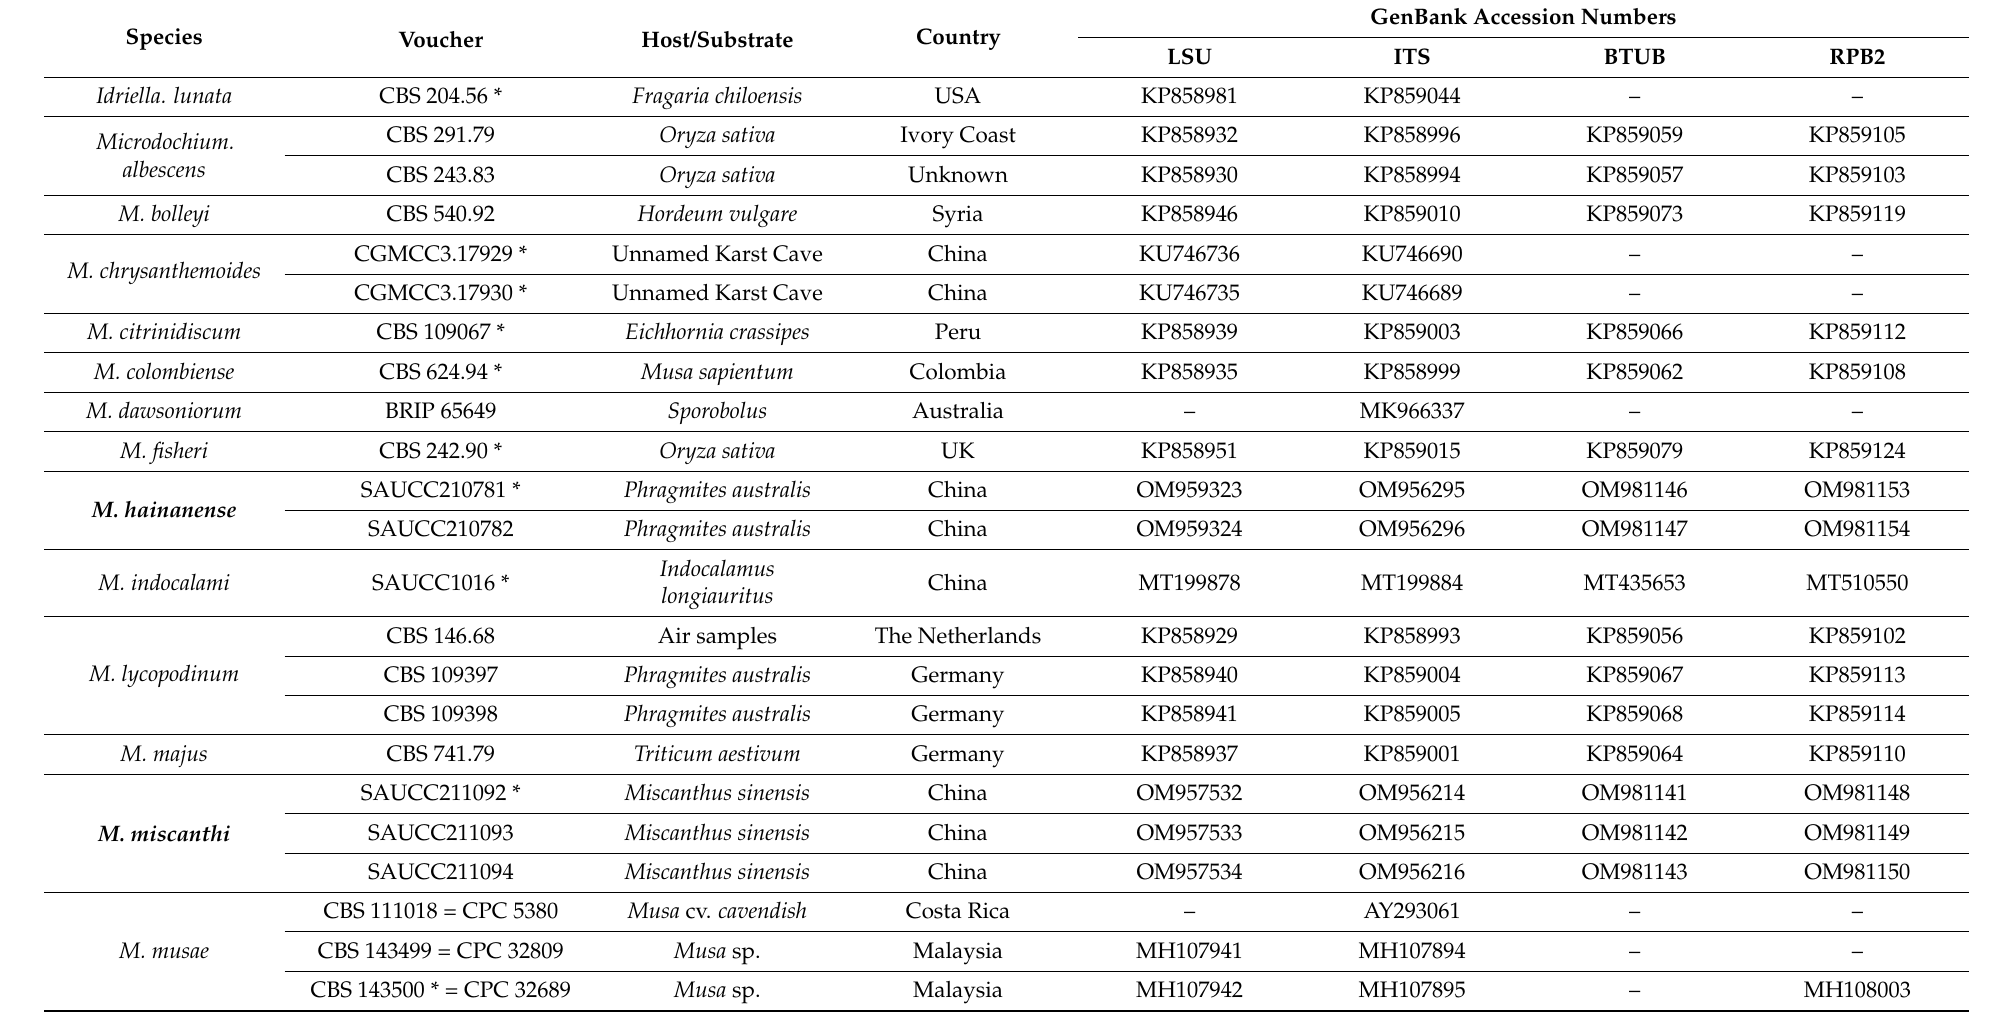
Table 1. Information of specimens used in this